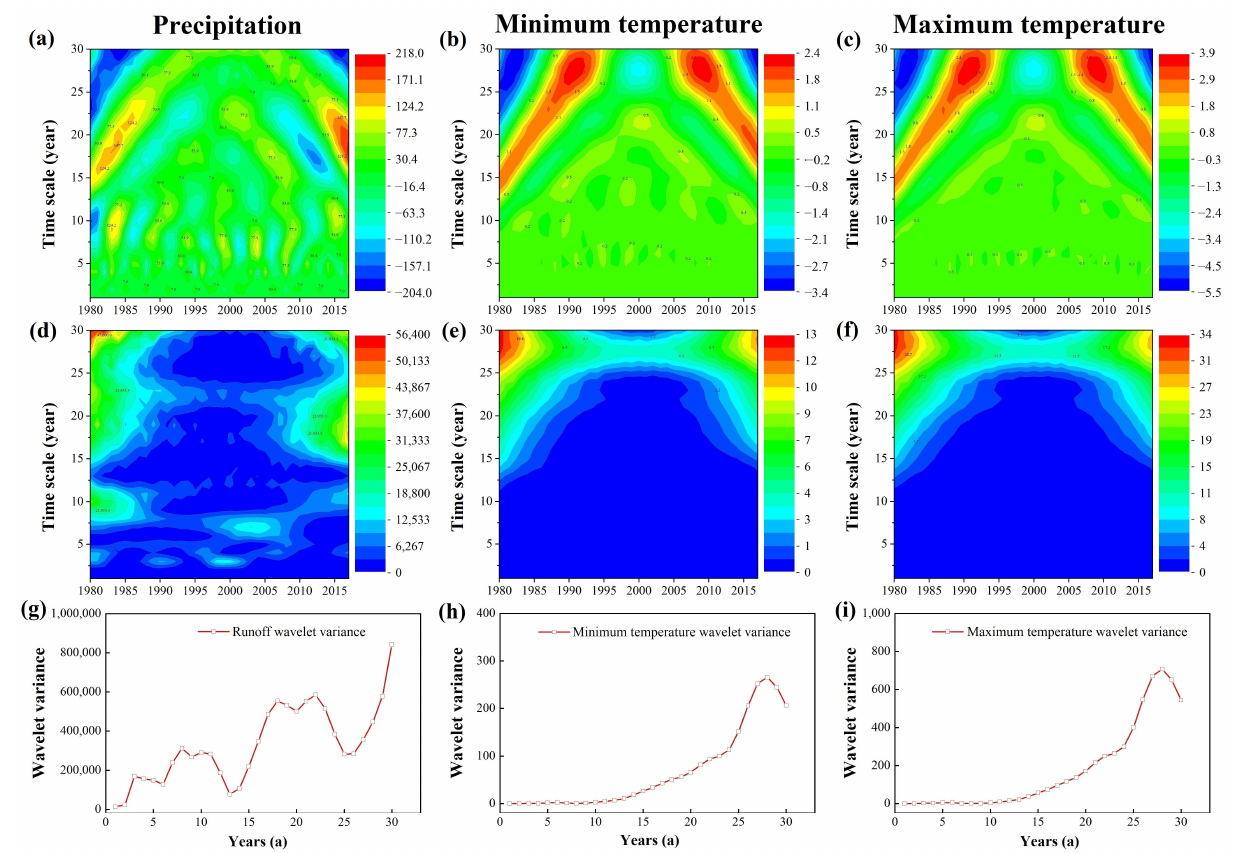
Figure 4. The real part ( a – c ), modular square ( d – f ) and wavelet variance ( g – i ) of Morlet wavelet transform coe ffi cient of precipitation, minimum and maximum temperature.